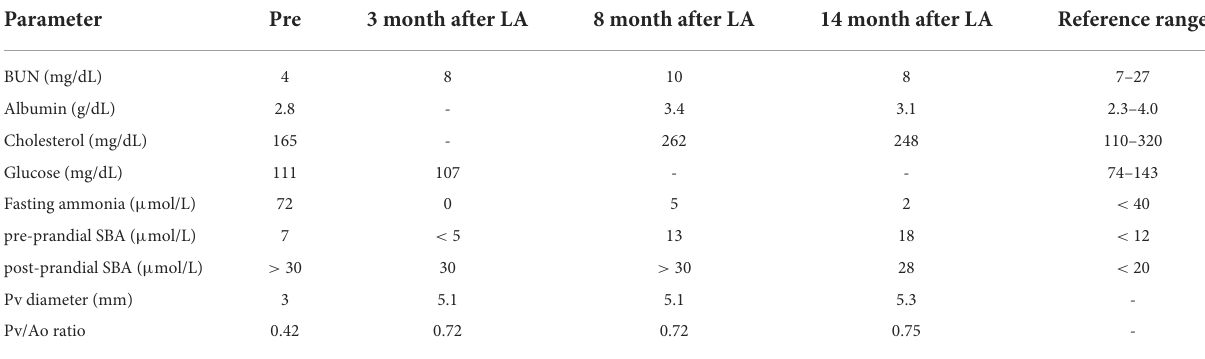
TABLE 1 Serum biochemical panel and portal vein diameter before and after laparoscopic attenuation of canine splenophrenic shunt.